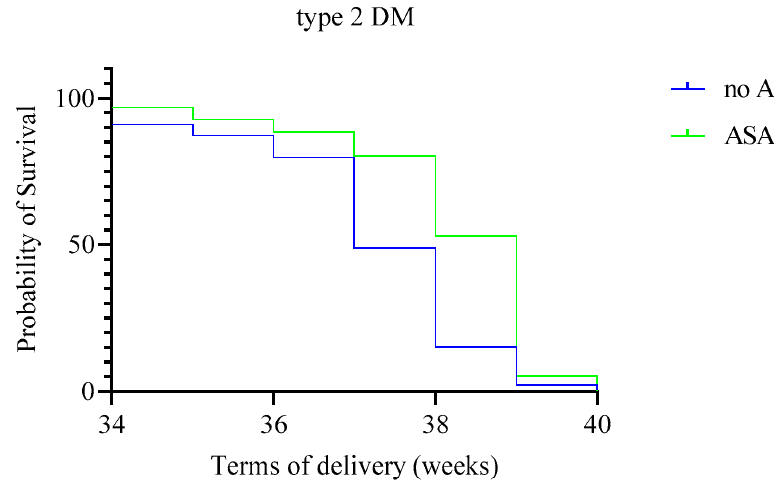
Figure 2. Terms of delivery in patients with type 2 DM.